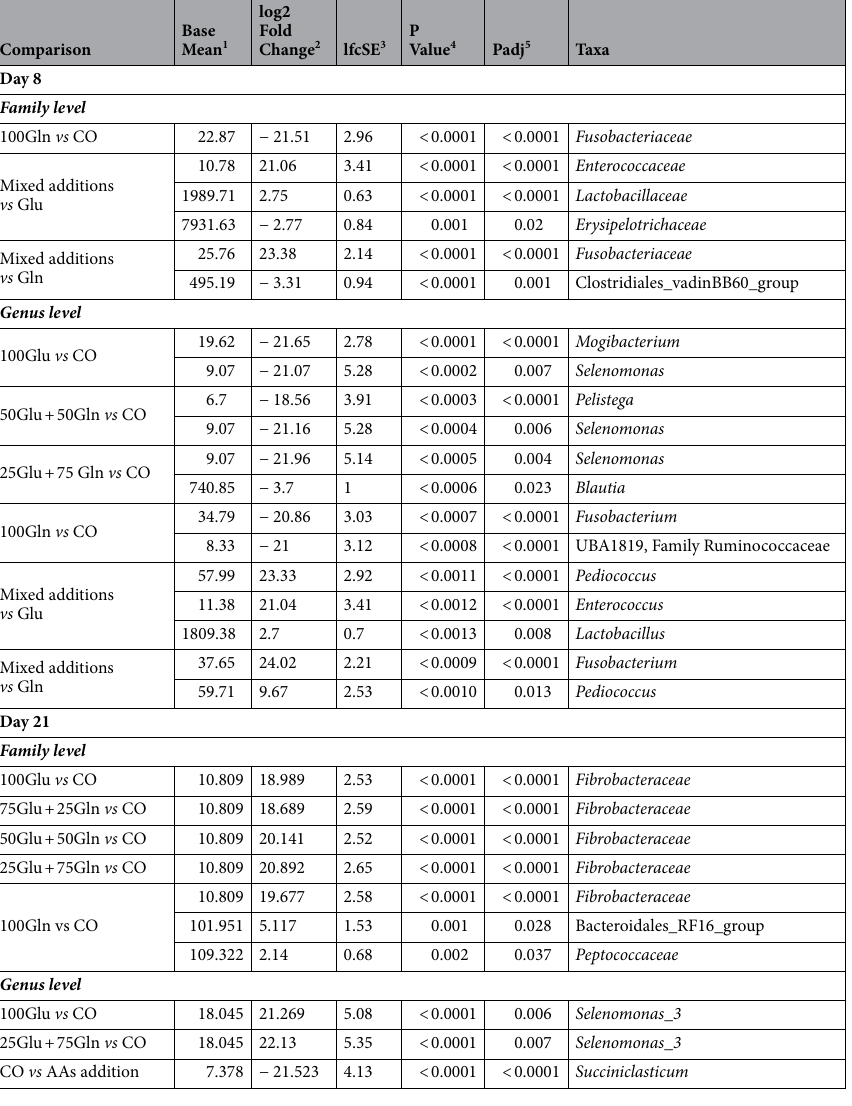
Table 3. Effect of the dietary supplementation (6 kg/T) with glutamate and glutamine in different ratio on microbial taxa composition of piglets at 8- and 21-days post-weaning. baseMean 1 = mean of normalized taxa counts averaged over all samples from both conditions. log2FoldChange 2 = log2 Fold Change. The sign is relative to the first group identified in the comparison. lfcSE 3 = log2 Fold change standard error. P value 4 = Wald statistic value. Padj 5 = Benjamini–Hochberg adjusted p